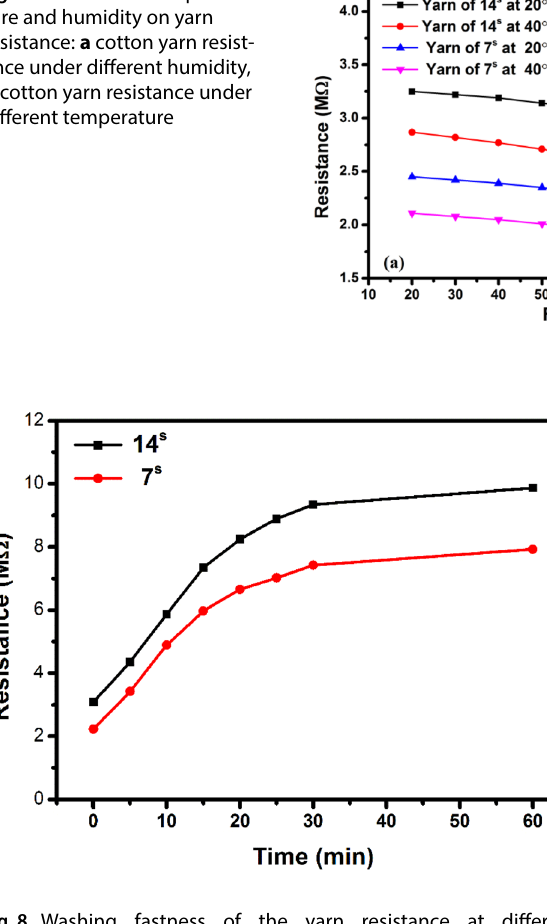
Fig. 8 Washing fastness of the yarn resistance at different immerged time in